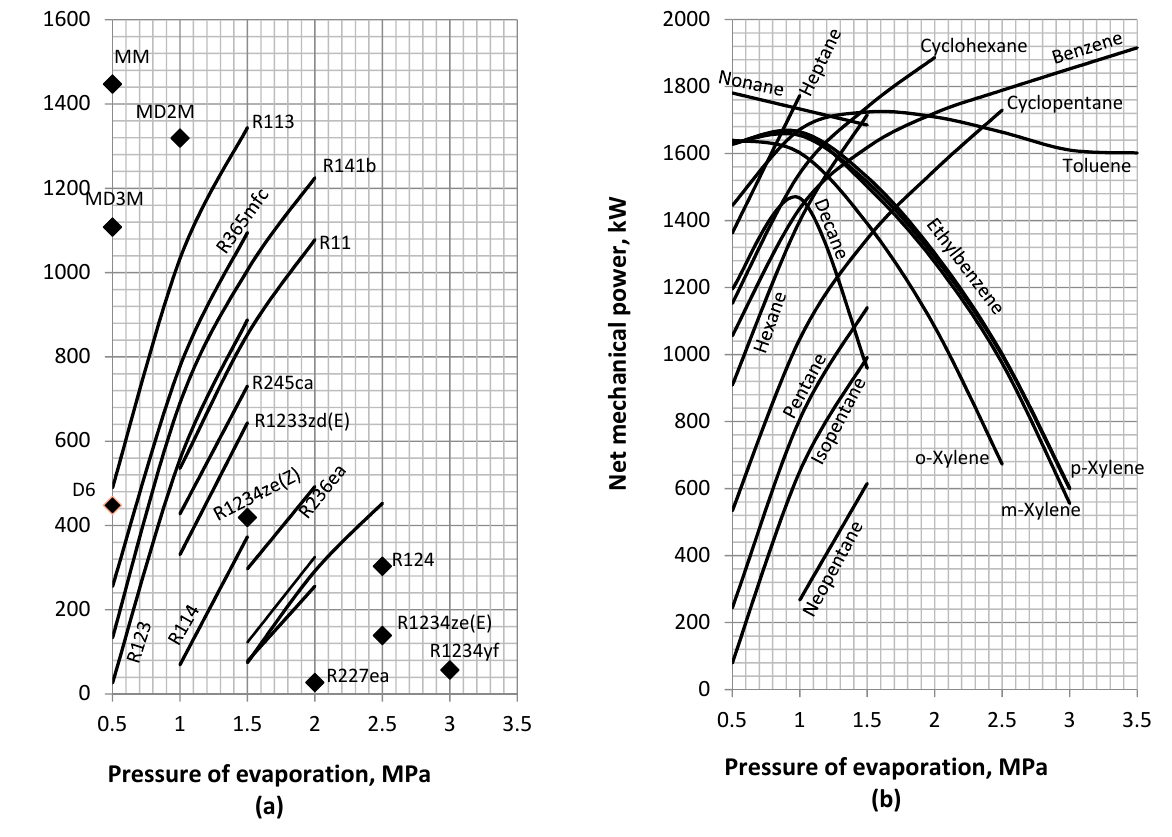
Figure 4. Net mechanical power output of the ORC cycle with refrigerants and siloxanes ( a ) and hydrocarbon ( b ) organic fluids.